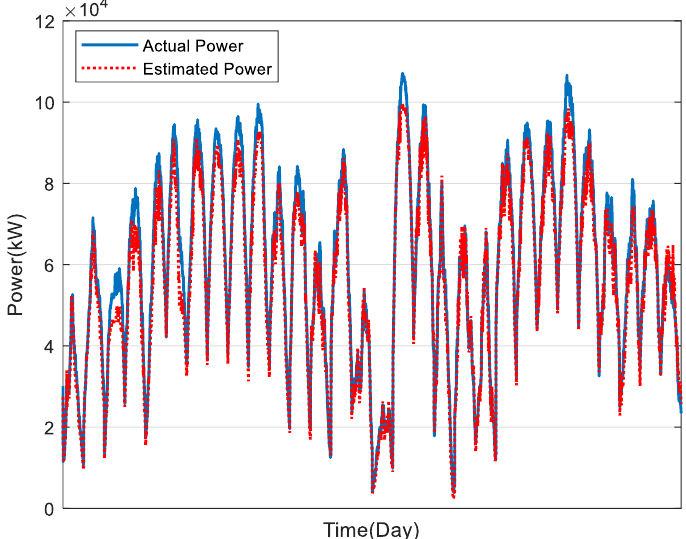
Figure 14. Results of PV power estimation in April.